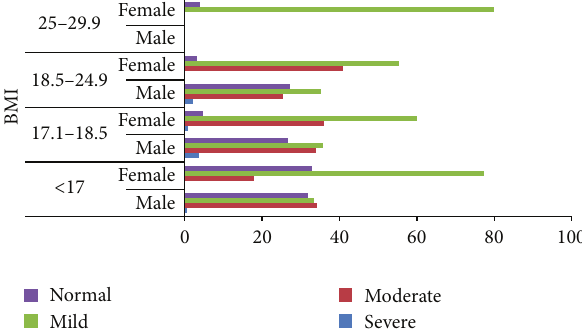
Figure 2: Prevalence of anemia as per different BMI categories among studied adolescents in Himalayan state of north India,